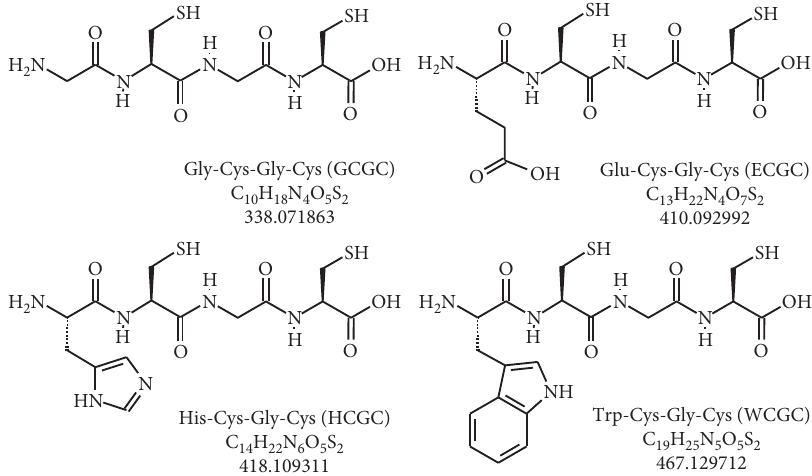
Figure 1: Chemical structures of bis-cysteinyl tetrapeptides and their monoisotopic